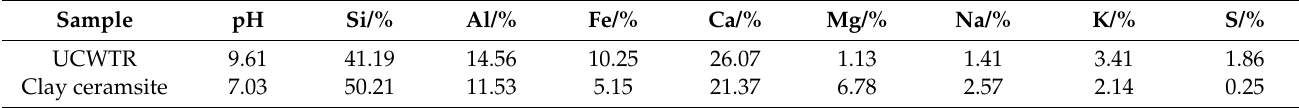
Table 1. Main components of